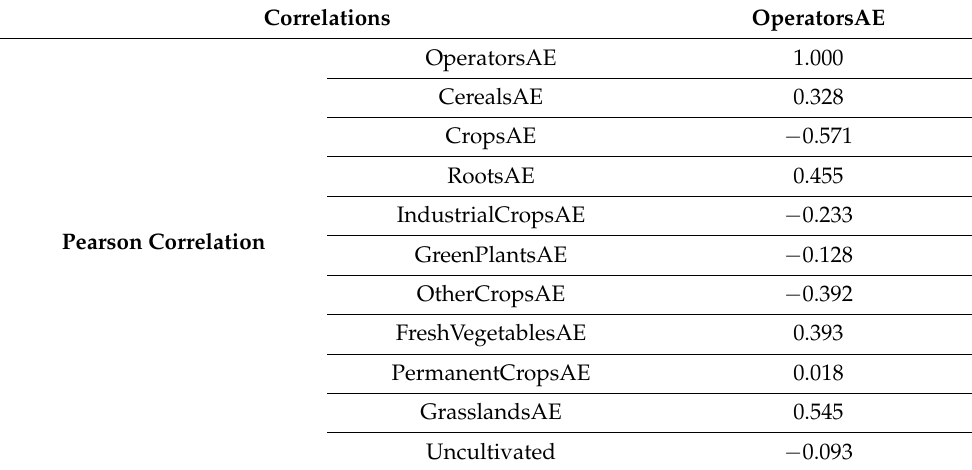
Table 3. Pearson